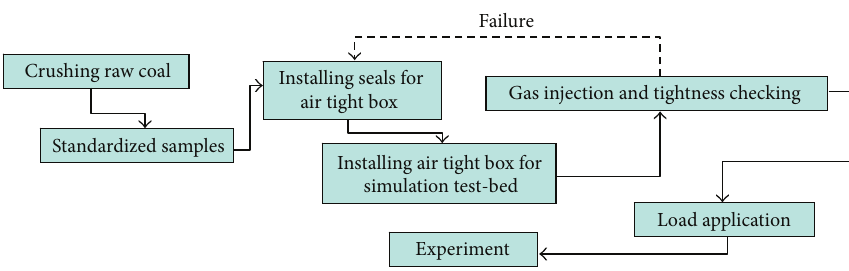
Figure 3: Flowchart of simulation test of coal and gas outburst.